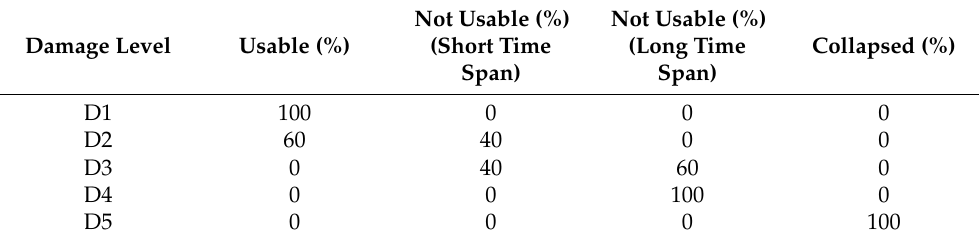
Figure 2. Framework for risk assessment. Table 4. Matrix 1—Percentage of damaged buildings. Reprinted with permission from [19]. Copyright 2021, Borzi et al.